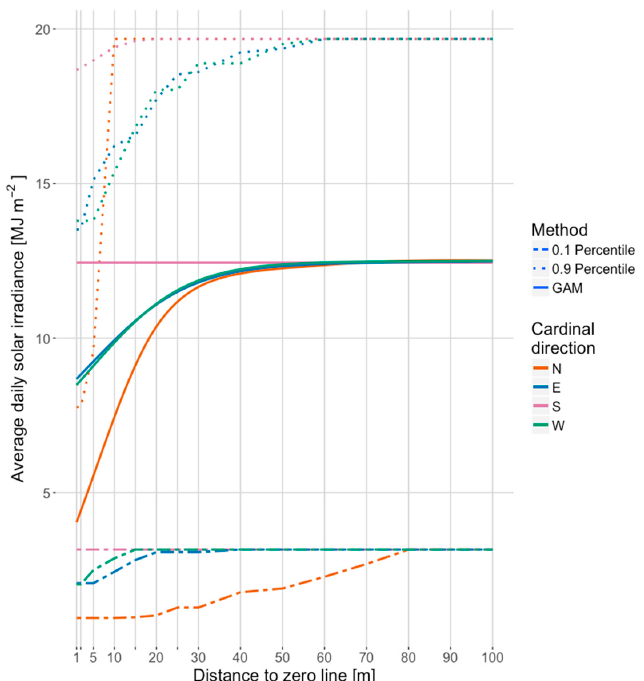
Figure 3. Simulated average daily solar irradiance for the four cardinal directions (north, east, south, and west) of the arable land, shaded by a forest, with respect to distance to the zero line. The solid lines represent the general additive models (GAM), fitted to the data, and the dashed lines represent the 0.1 and 0.9 percentile.